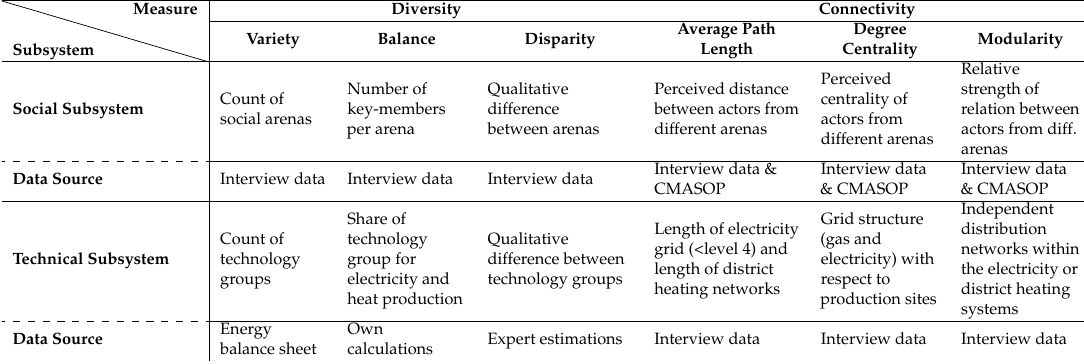
Table 3. Measures for the indicators in the social and technical